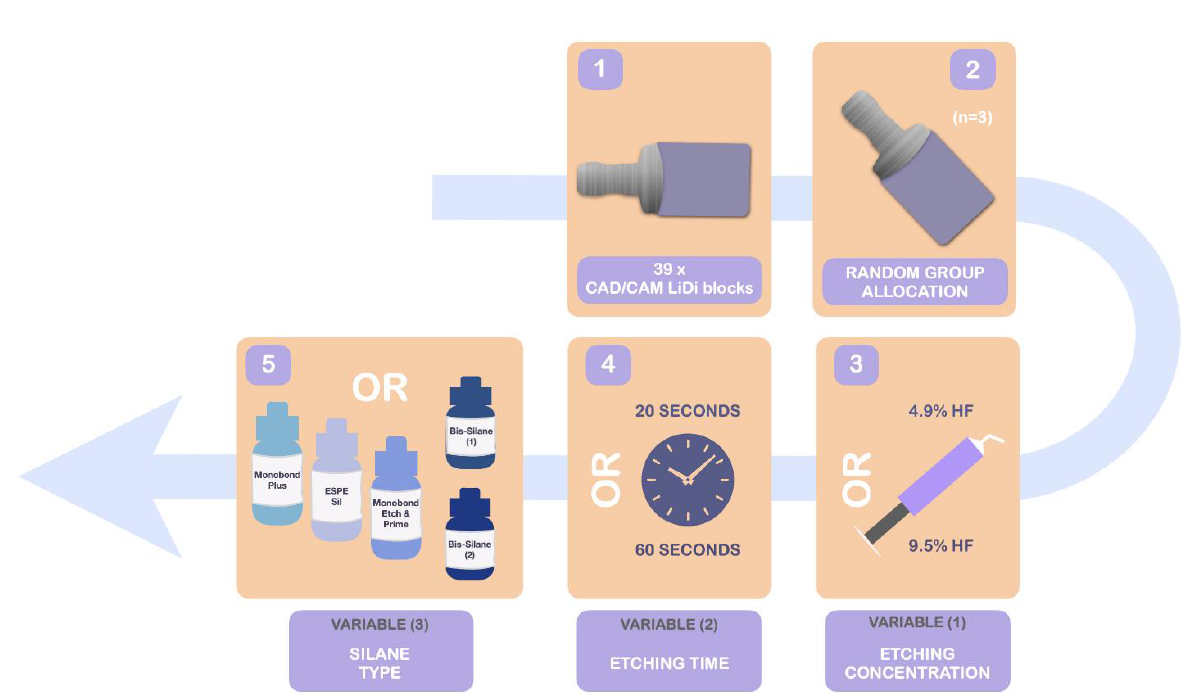
Figure 1. Experimental design featuring block preparation, random allocation and division according to the three variables under study.